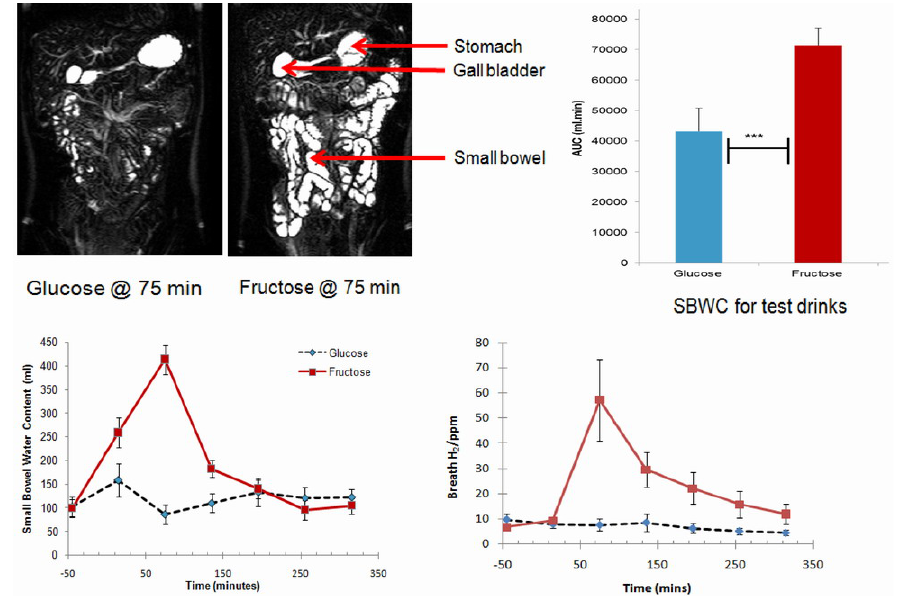
Figure 2. Small bowel water content (SBWC) and breath hydrogen (H2) concentrations after drinking each of the drinks: glucose and fructose. The time of drinking ( t = 0 min) is highlighted in the chart. Values of SBWC are mean volume (mL) ± s.e.m (standard error of mean). Values of H2 are mean concentration (p.p.m.) ± s.e.m. Figure modified from